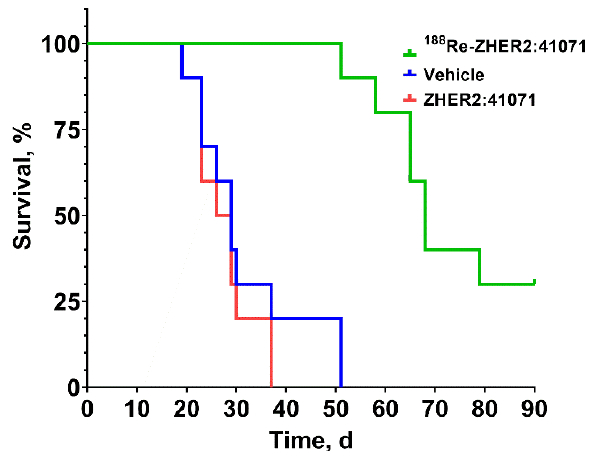
Figure 11. The survival of mice treated with 188 Re-ZHER2:41071 (three times with 5 µg, 16 MBq, dissolved in 10% ethanol in 0.9% saline), non-labeled ZHER2:41071 (three times with 5 µg, dissolved in 10% ethanol in 0.9% saline), and vehicle (three times with 10% ethanol in 0.9% saline).